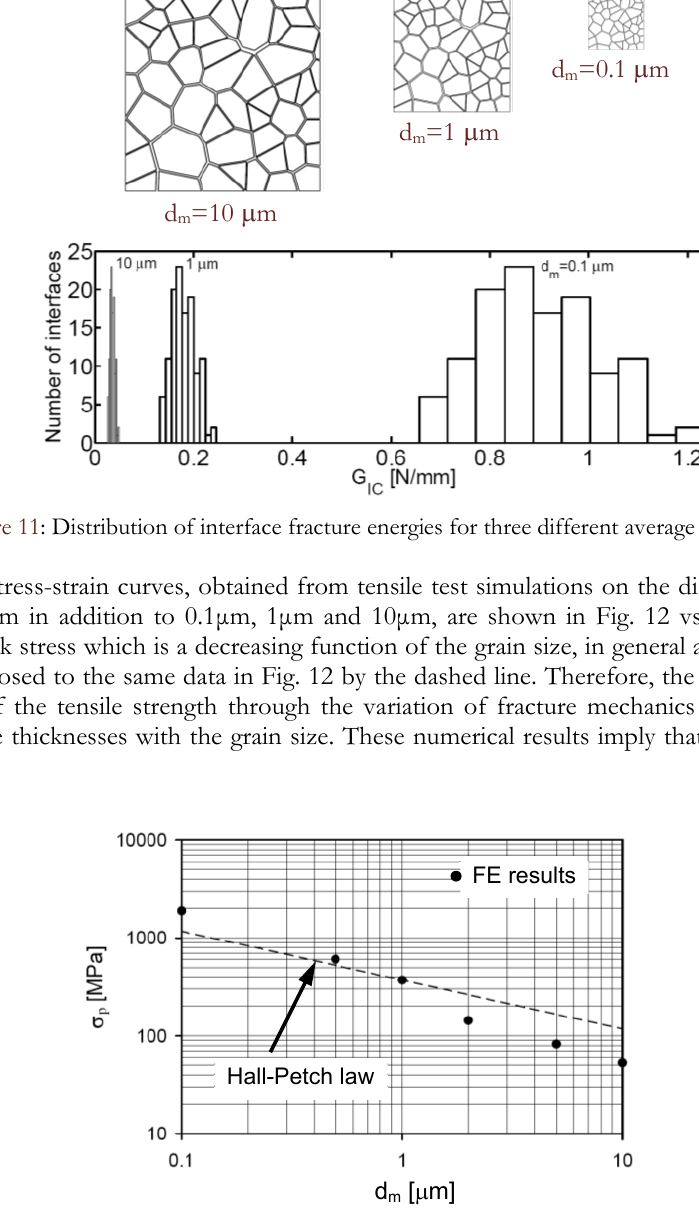
Figure 12: Numerically predicted vs. experimentally obtained peak stress vs. average grain